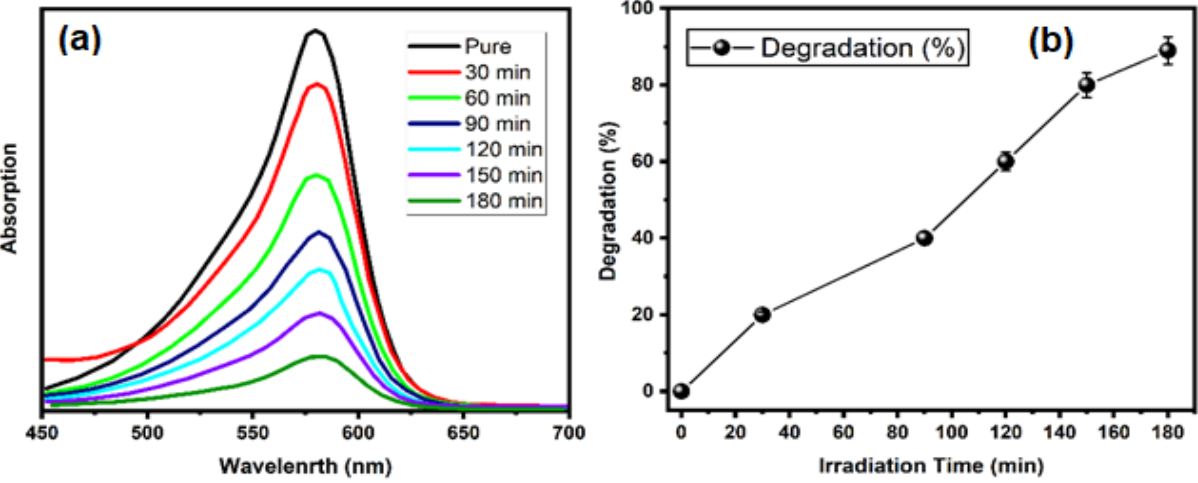
Figure 7. ( a ) Absorption spectra (UV-Vis) of photodegraded bromophenol blue by TiO 2 and, ( b ) their % degradation at various time intervals.